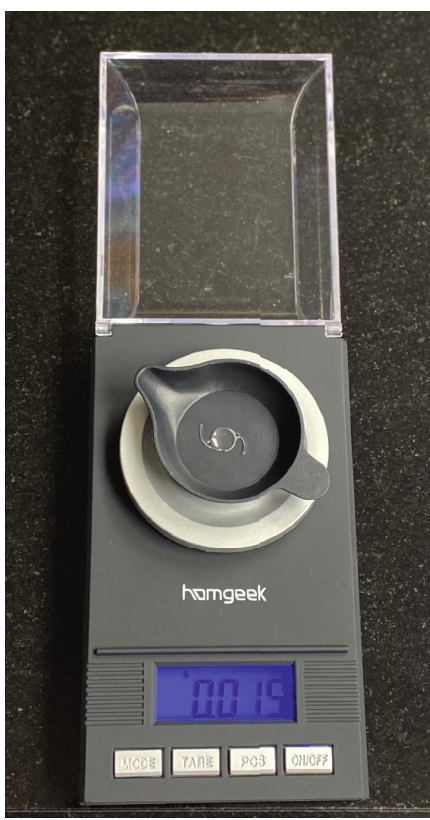
Figure 1: The balance used to weigh the intraocular